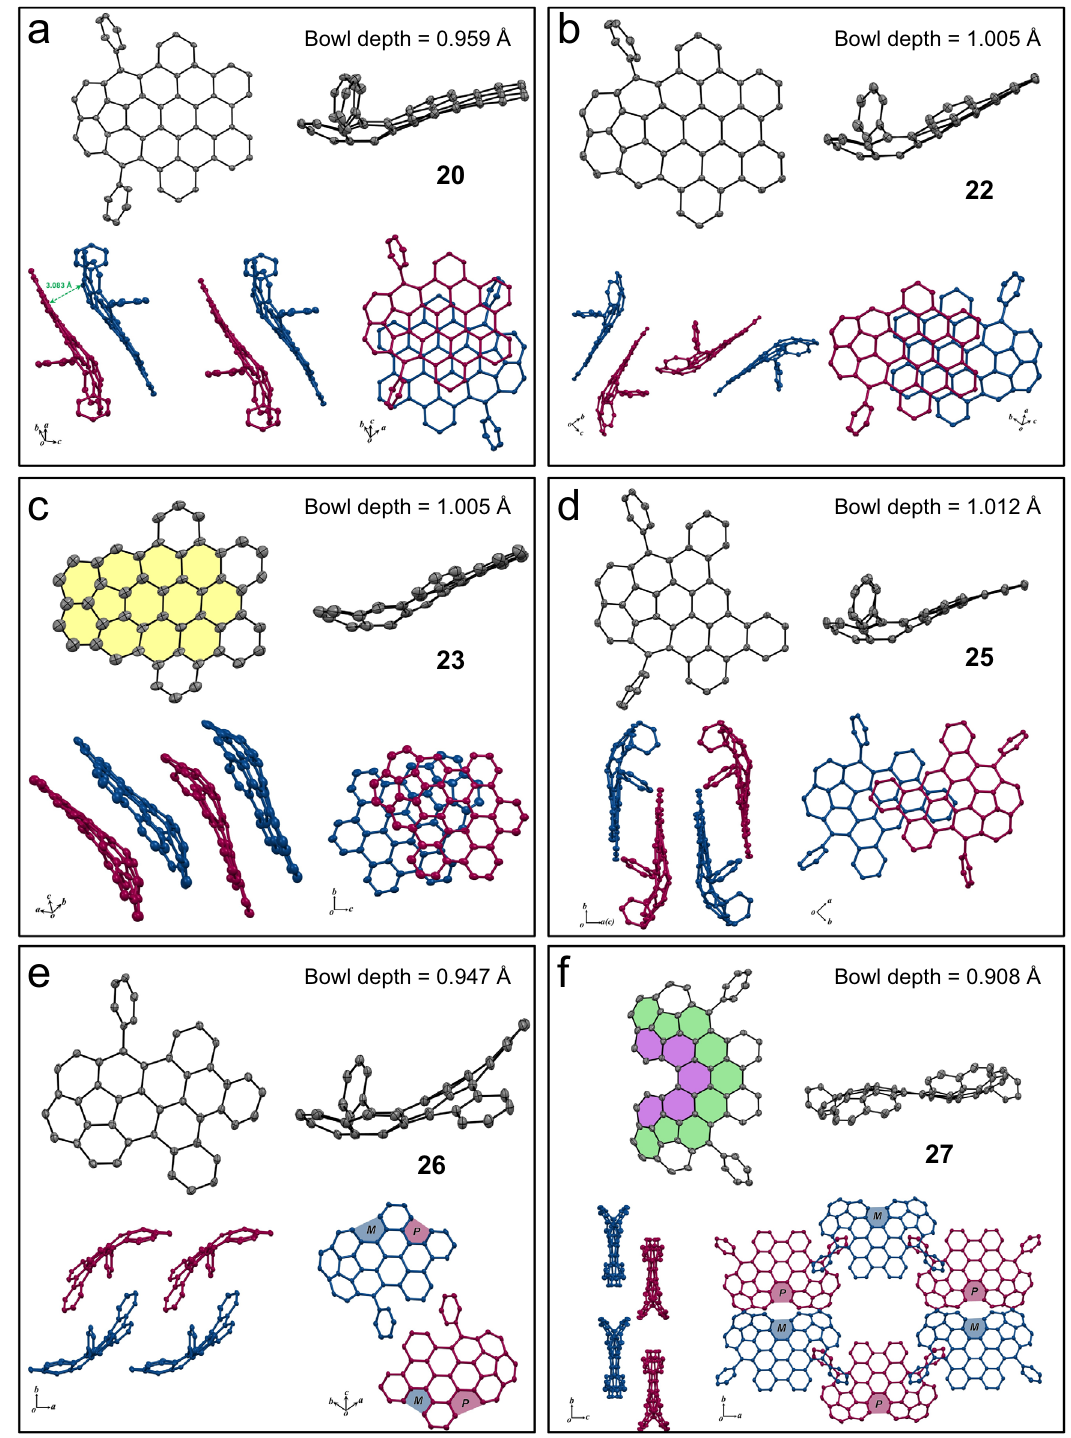
Fig. 5 | X-Ray crystal structures of nanographenes. Thermal ellipsoids were scaledat50%probabilitylevel. tert -Butylgroupsandhydrogenatomswereomitted for clarity. Top view, side view, and packing structures are shown in a clockwise